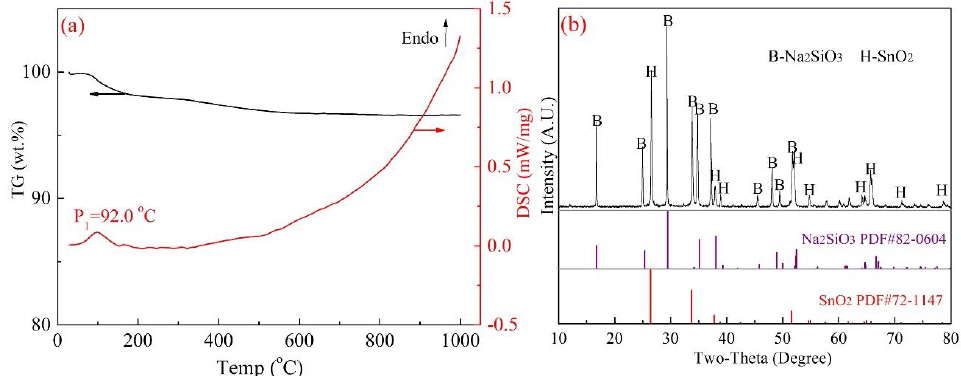
Figure 8. Reactions between Na 2 SiO 3 and SnO 2 (( a )-TG DSC analysis, ( b )-XRD analysis of the TG products).